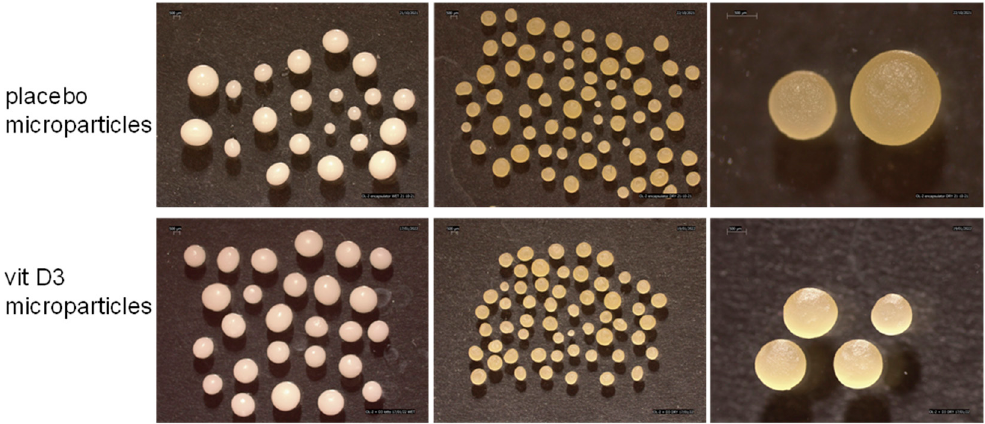
Figure 3. Stereomicroscope images of wet and dried microparticles. Wet microparticles were milky because they assumed the colour of the loaded emul- sion. After drying, during which water evaporated, the content of microparticles was represented principally by oil blend (placebo systems) or vit D3 oily solution and the colour of the systems turned to glossy